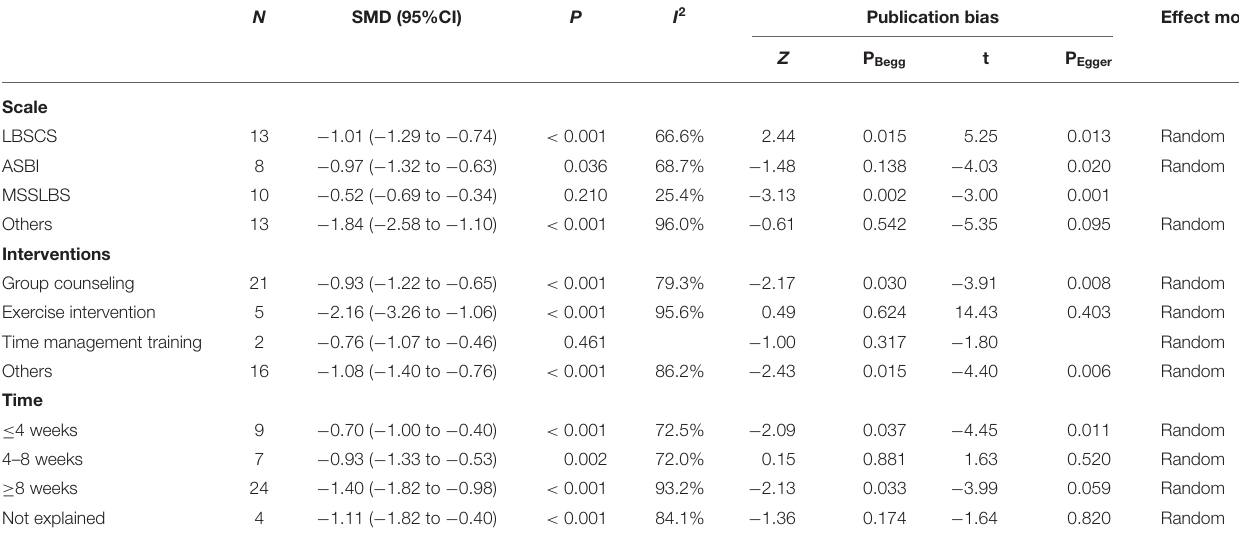
TABLE 2 | Subgroup analysis of the included